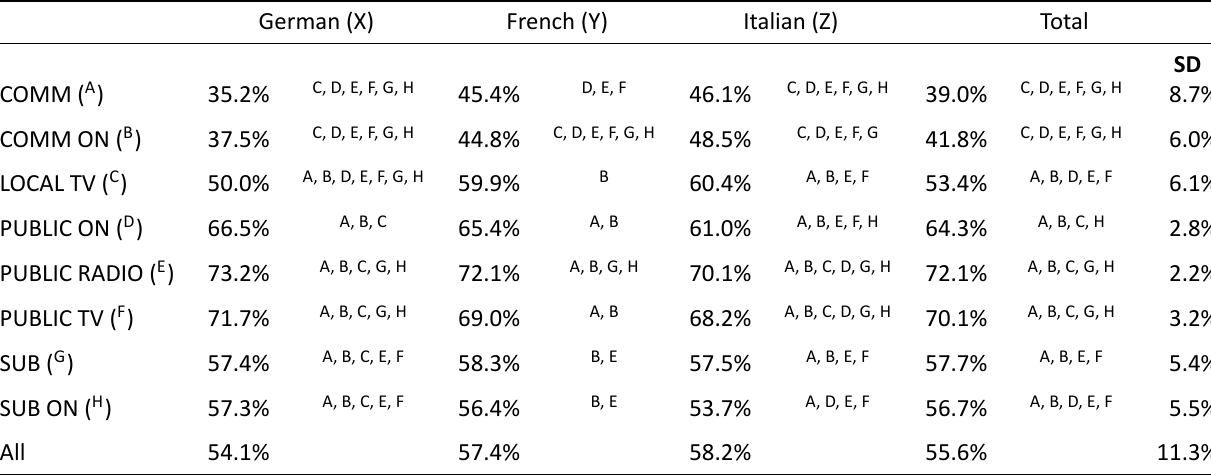
Table 4. Average quality scores by media type and language